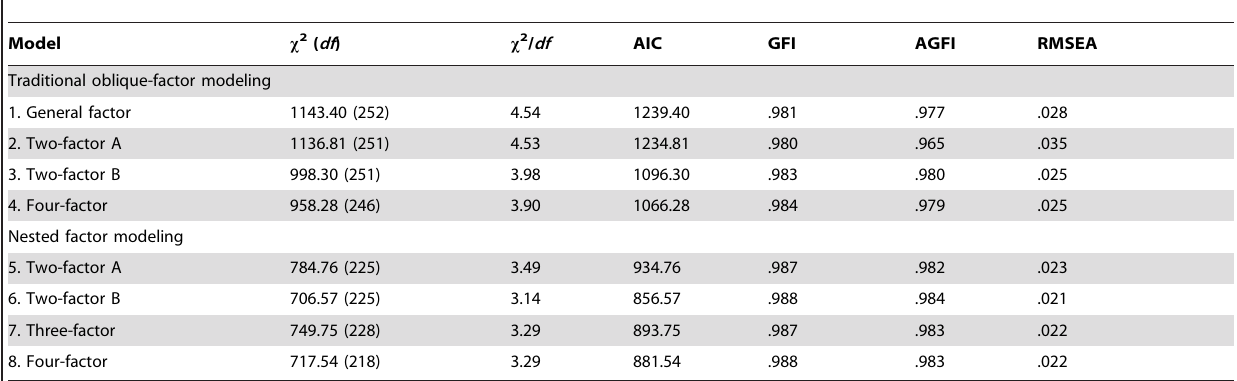
Table 2. Exact and close-fit statistics/indices (WLS) for TIE models.